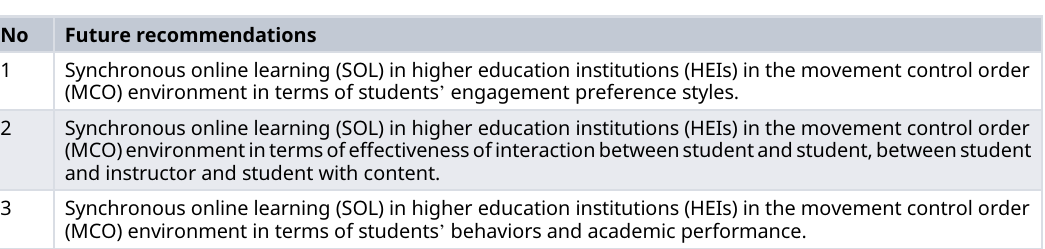
Table 9. Future research